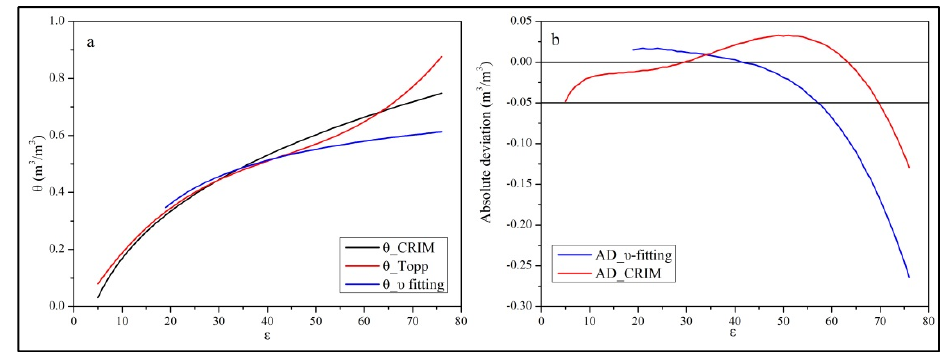
Figure 15. Comparisons between CRIM, υ -fitting equations and the Topp equation (a) and their absolute deviation (b).